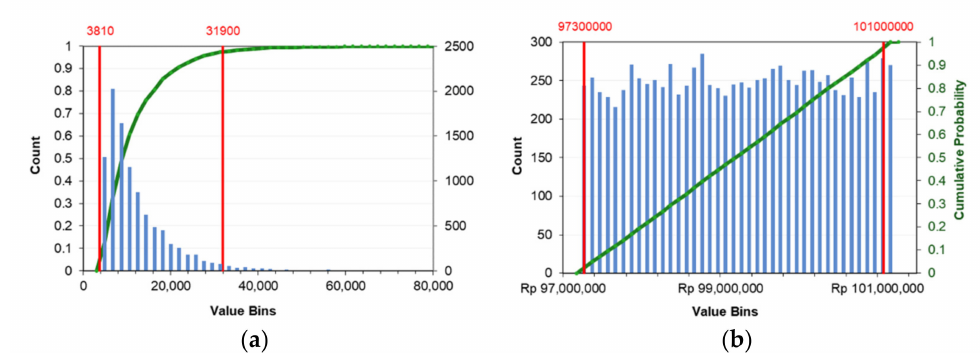
Figure 14. Histogram of BEP through MCS on Overhead Crane: ( a ) Break-Even of Units; ( b ) Break- Even Revenues.